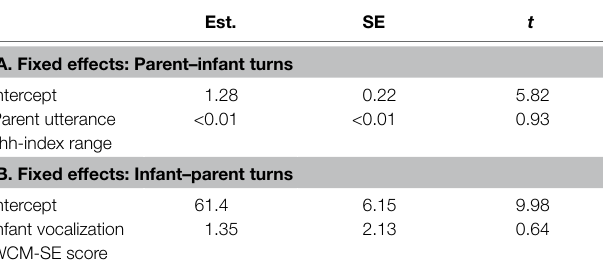
TABLE 6 | Summary of the fixed effects of the analysis of the measure vhh-index range in parent–infant turns (A) and infant–parent turns (B). No significant effects were found.